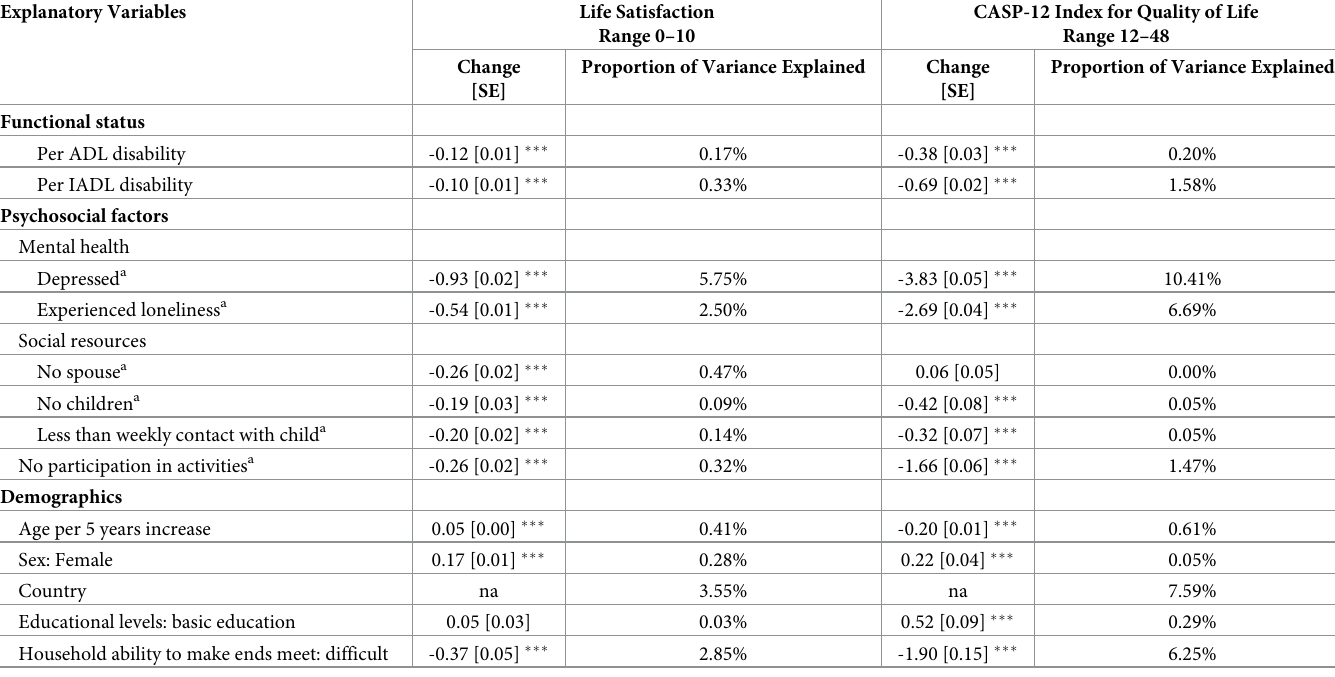
Table 2. The effects of functional status, psychosocial factors, and demographics on life satisfaction and quality of life. Explanatory Variables Life Satisfaction